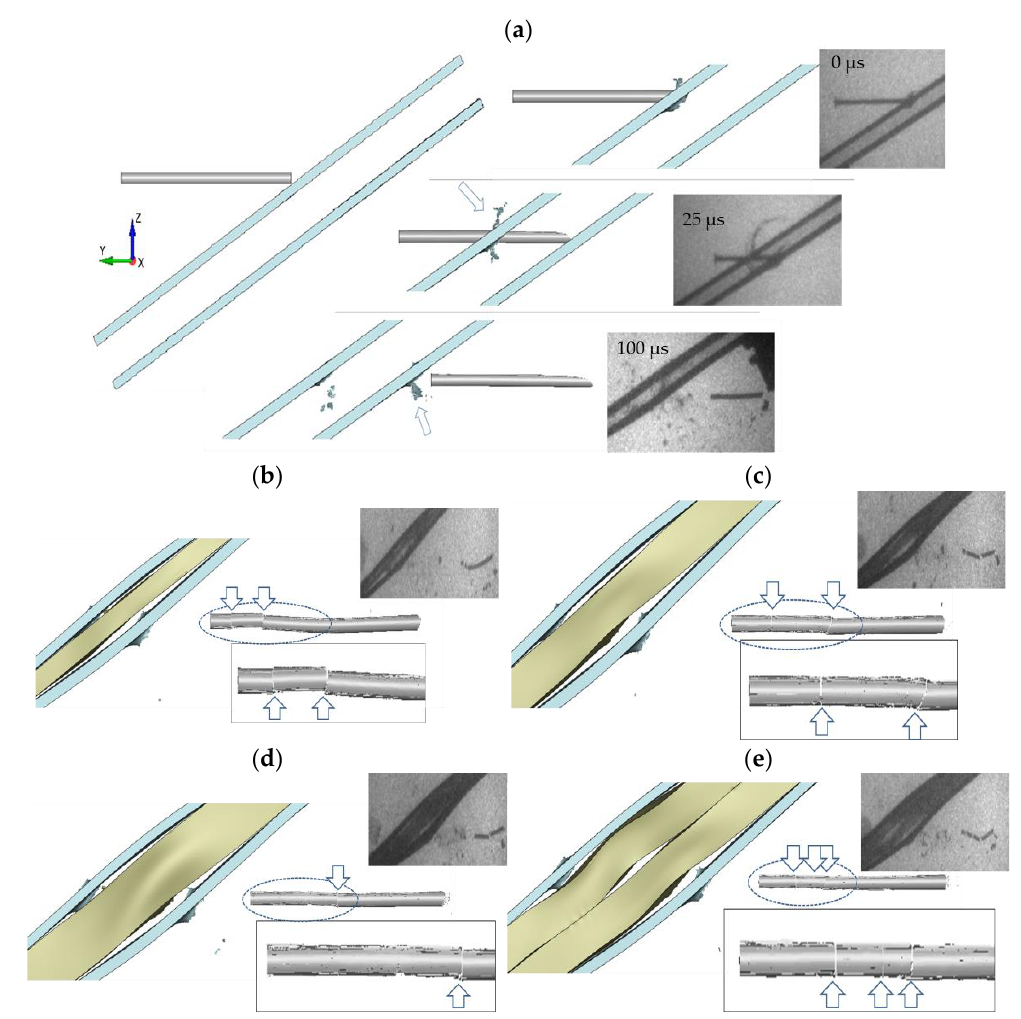
Figure 9. Numerical and experimental results for the configurations: ( a ) without the rubber interlayer, ( b ) with a 5 mm, ( c ) 10 mm, ( d ) 15 mm, and ( e ) 2 × 10 mm thick rubber layer.